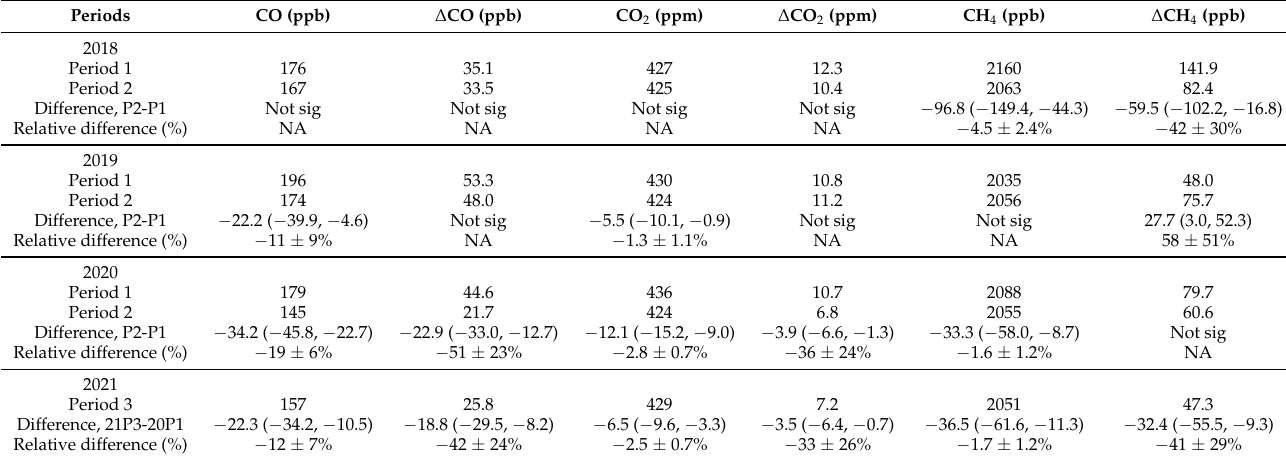
Table 3. Means of daily afternoon (12:00 to 16:00 local time) mole fractions and enhancements above background of CO, CO 2 and CH 4 during Period 1 and Period 2 for 2018 to 2020 and Period 3 for 2021. “Difference” for 2018–2020 is the mean of Period 2 minus the mean of Period 1. In the last row of 2021 results, the differences are calculated as 2021 Period 3 minus 2020 Period 1. “Difference” is given with the 95% confidence interval. “Relative difference (%)” is given with uncertainties calculated from the 95% confidence interval of the difference. “Not sig” means the t -test p > 0.05, and the difference is not statistically significant. “NA” means not applicable, because the difference is not